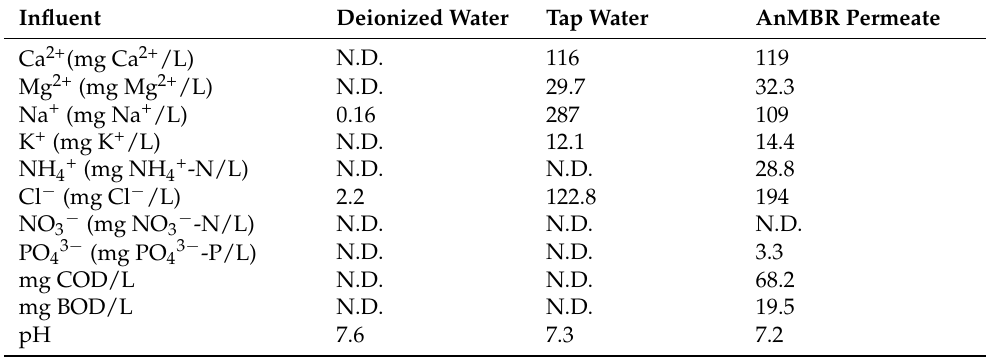
Table 1. Characterization of the different solutions used for adsorption kinetics and isotherms.